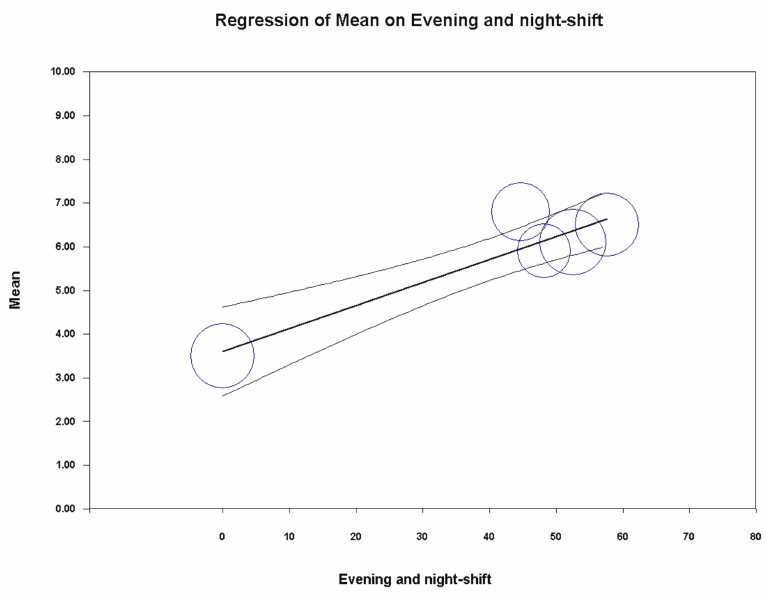
Figure 10. Meta-regression analysis showing a statistically significant association between the pooled PSQI global score in police officers and the percentage of policemen on evening/night